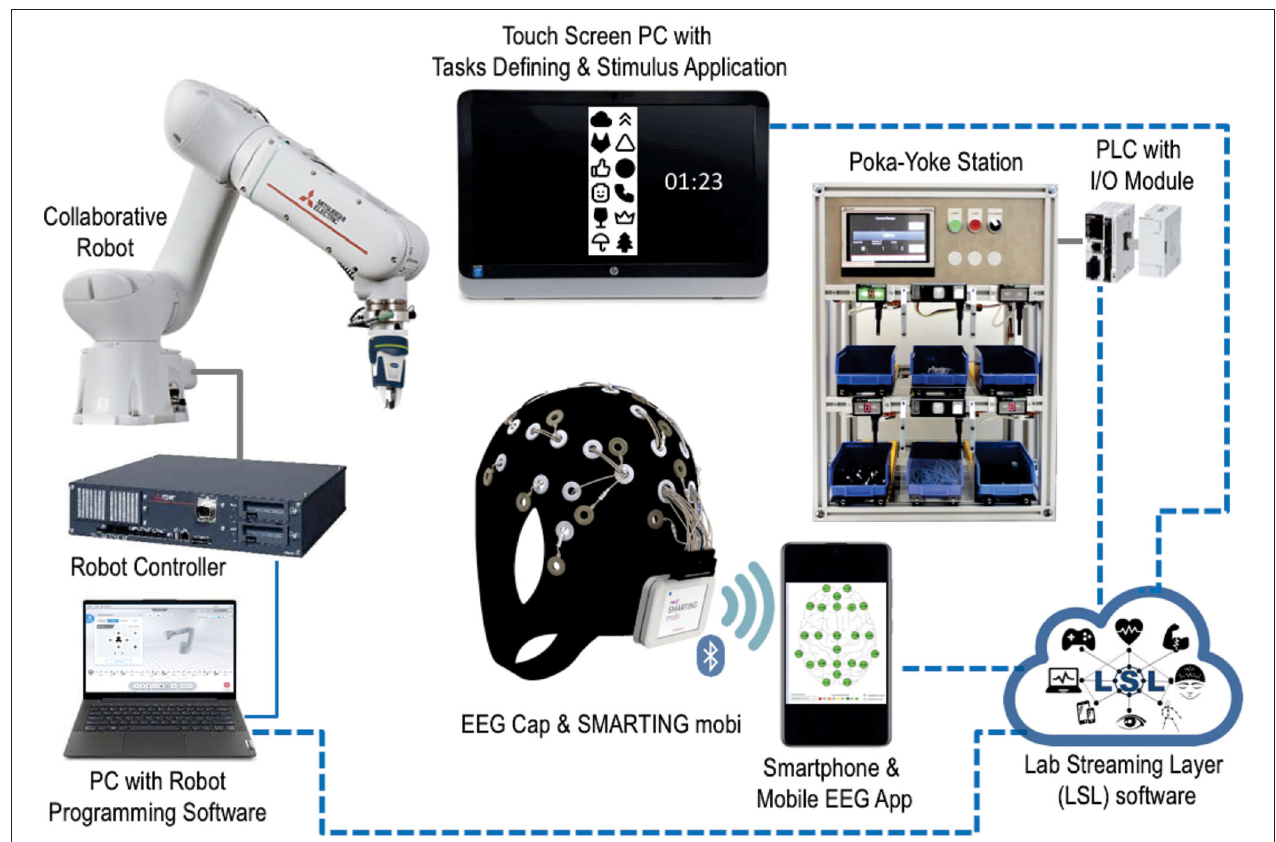
FIGURE 3 | LSL integration of key measurement set-up